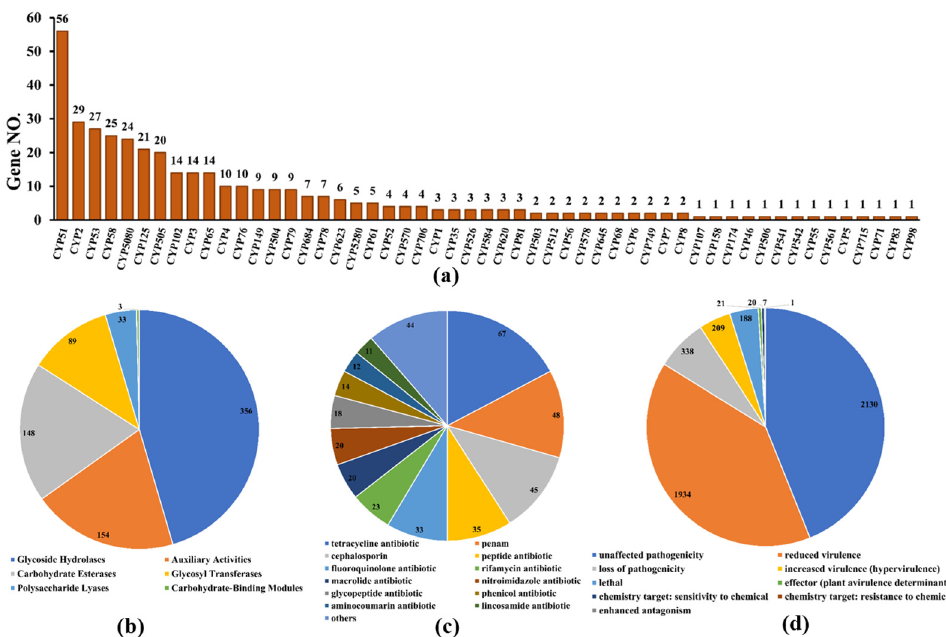
Figure 7. Additional annotation of D. alcacerensis CT-6 genes: ( a ) CYP450 annotation; ( b ) CAZy functional classification; ( c ) Antibiotic-resistance gene prediction; ( d ) Pathogen–host interaction phenotype classification.